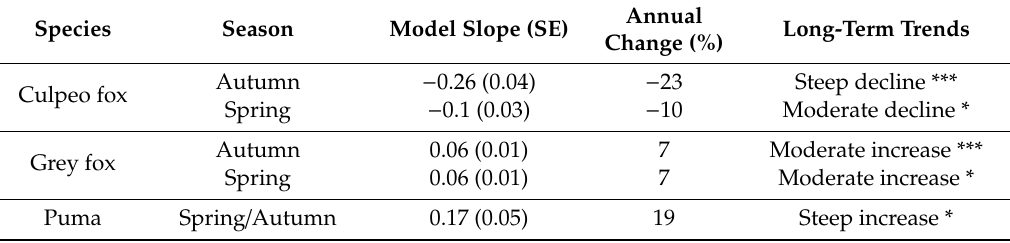
Figure 2. Culpeo (black dots) and grey fox (grey triangles) population trends based on the imputed trend indices estimated by the most parsimonious time-e ff ect model (stepwise time e ff ect model; Supplementary Material Table S1) for each season: autumn (2000–2013) and spring (2000–2012). Time-points identified by the model as significant change points on the population trends are marked with asterisks (*) for the culpeo fox and hashes (#) for the grey fox. Vertical bars represent the SE of trend indices. Horizontal dashed lines represent the index value for the base year (2000). Table 1. Population trends of the culpeo fox, grey fox and puma in the BPJNP from count data spanning 2000–2013. The model slope and the mean annual percent change ( +/ − ) are